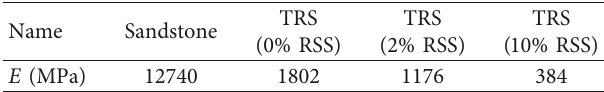
Table 3: Elastic modulus for sandstone and transparent rock specimens in the UCS